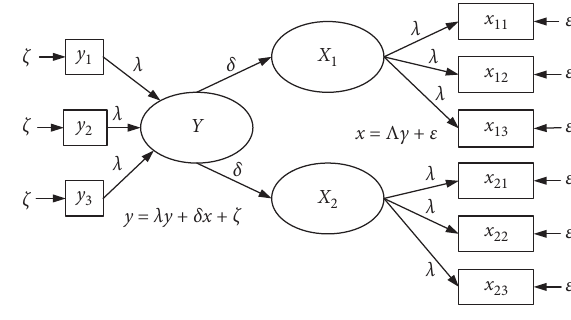
Figure 3: Structural equation model